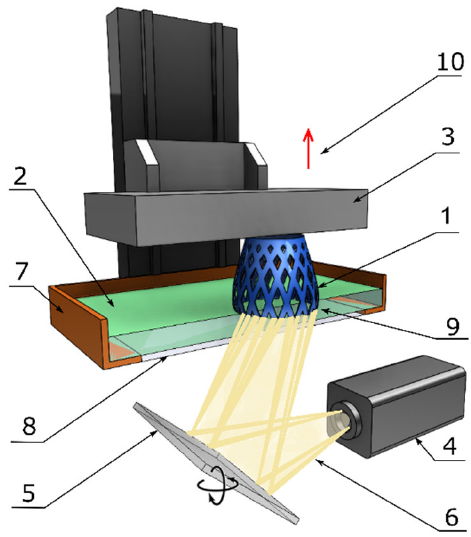
Figure 7. Components of a typical CDLP/CLIP machine: 1—printed part, 2—liquid resin, 3— building platform, 4—light source, 5—digital projector, 6—light beam, 7—resin tank, 8—oxygen- permeable window, 9—dead zone, and 10—continuous elevation.